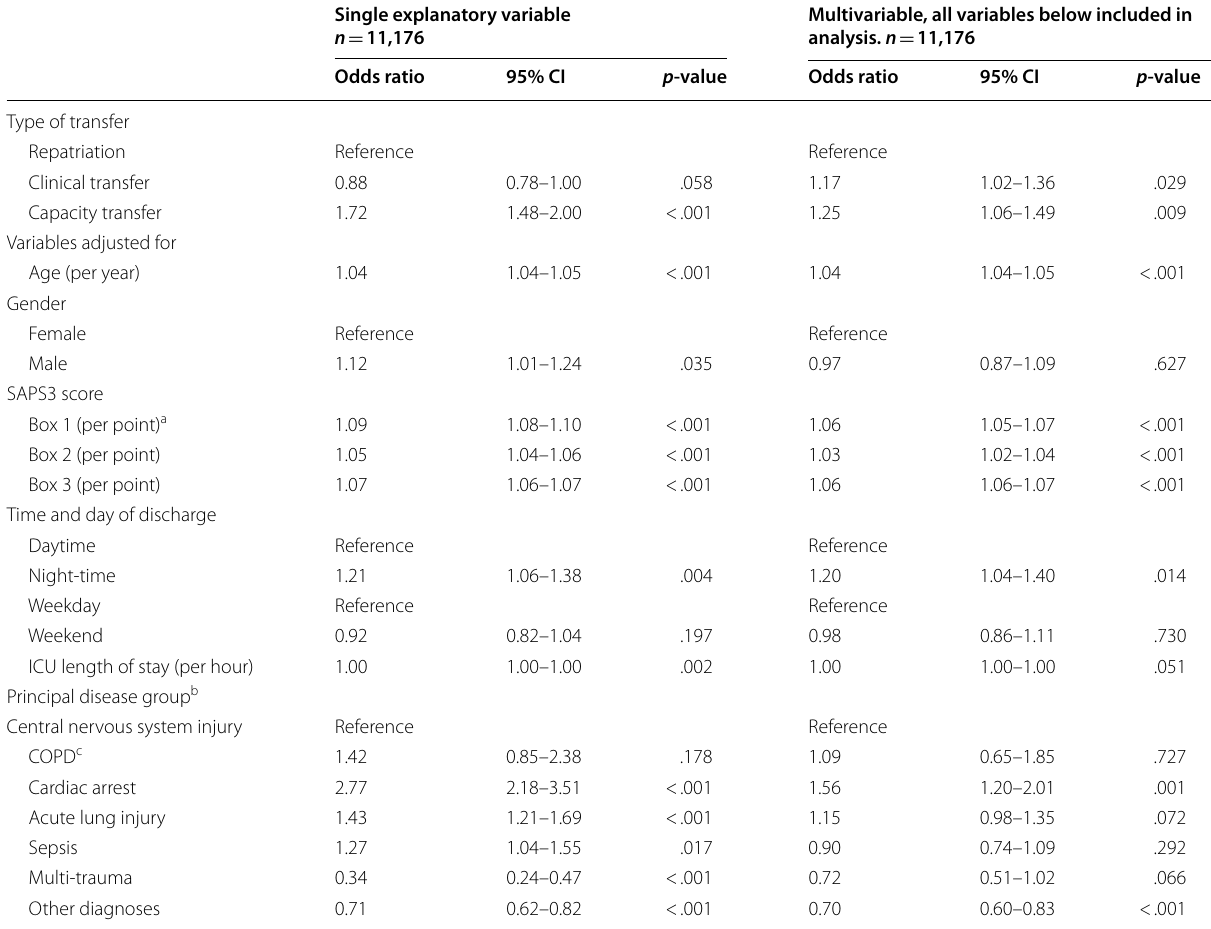
Table 2 Association between covariates and 30-day mortality